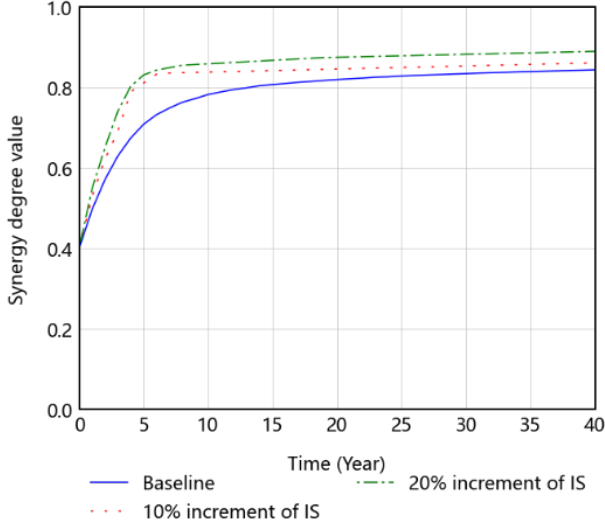
Figure 14. The effects of different degrees of IS on synergy.